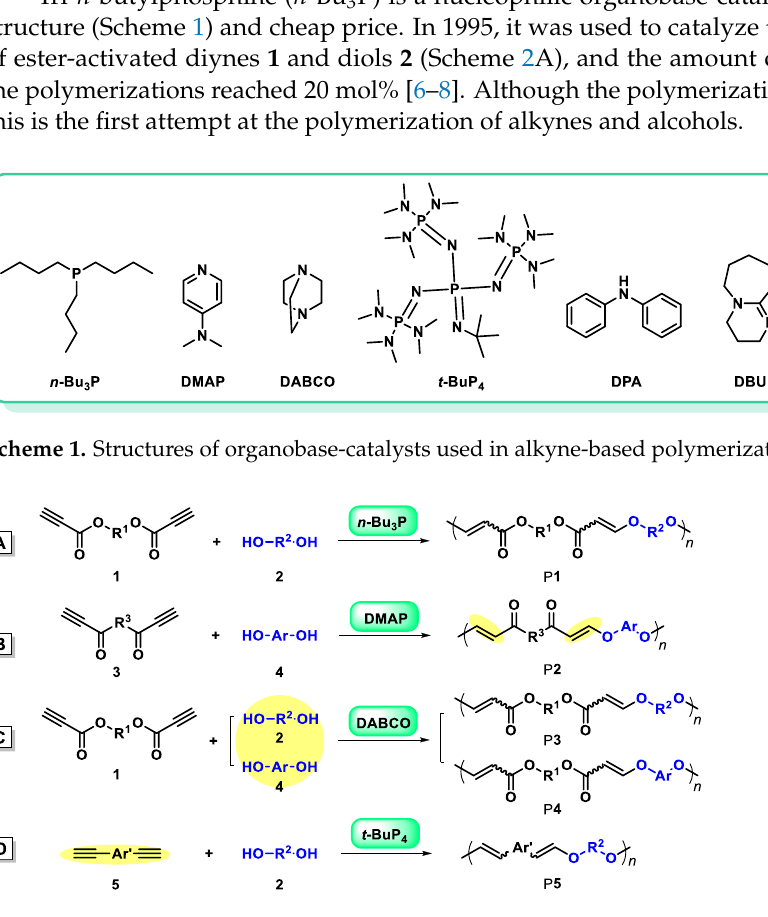
Figure 1. ( A ) The plots of the weight-average molecular weight ( M w , solid blue line) and percentage of degradation (dash pink line) of P 2-1 versus different concentrations of hydrochloric acid. (Copyright 2017, Wiley) ( B ) Stern – Volmer plots of I 0 / I − 1 of P 5-1 in tetrahydrofuran /water mixtures ( f w : 80%) and P 5-1 in a THF versus PA concentration, where I = peak intensity and I 0 = peak intensity at [PA] = 0 μg/mL. Inset: the chemical structure of PA and fluorescence images of P 5-1 containing strips (a, b, c, d, and e represent strips after dipping into 0, 5000, 500, 50, and 5 μg/mL aqueous solutions of PA) upon irradiation with a hand-held lamp (365 nm). n -Bu 3 P or DMAP could only catalyze the diol-yne or phenol-yne polymerization, re- spectively, in the above two studies. Afterwards, researchers found that a more efficient organobase of bicyclo[2.2.2]-1,4-diazaoctane (DABCO) could catalyze both diol-yne